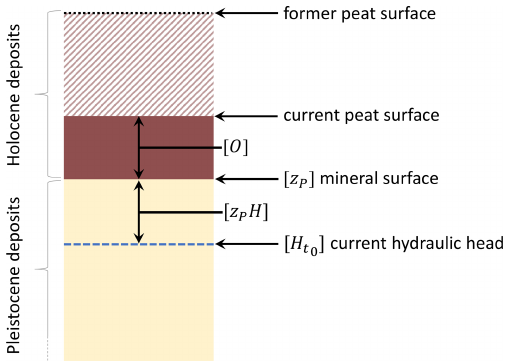
Figure 5. Schematic depiction of the covariates ( O , z P , z P H ). For explanation see Sect.